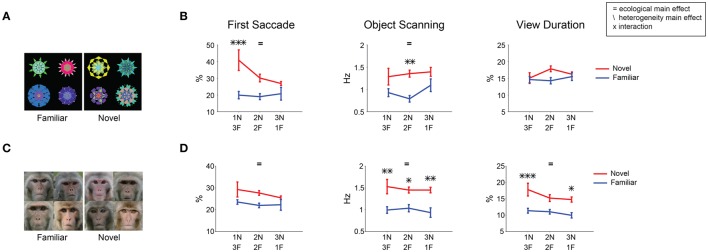
Changes in novelty salience by varying its prevalence. Free viewing trials were grouped into 3 display conditions: 1-novel/3-familiar, 2-novel/2-familiar, 3-novel/1-familiar objects, and analyzed for each gaze metric. (A,B) Novel/familiar fractals. (C,D) Novel/familiar faces. In both stimulus category and across the gaze metrics, novelty bias was observed regardless of condition (blue did not cross over red). Main effect of ecological factor and display condition as well as the interaction between the two are marked. Post-hoc tests are marked with asterisks.